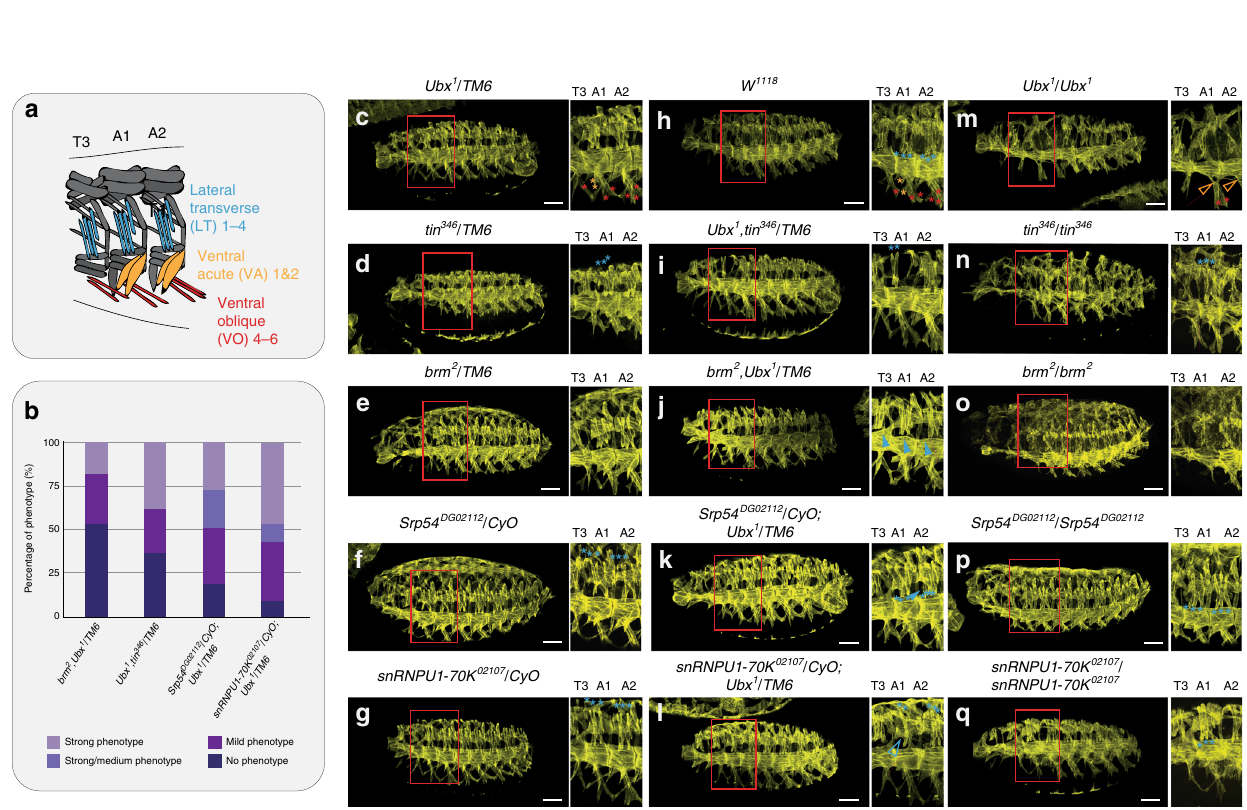
Fig. 6 Mesoderm-speci fi c functional cooperation of Ubx with BioID interactors. a Schematic illustration of the muscle patterns in the thoracic segment 3 (T3) and the fi rst two abdominal segments (A1, A2). Lateral transverse (LT) muscles are highlighted in blue, ventral acute (VA) muscles in orange and ventral oblique (VO) muscles in red, corresponding muscles in all the images are marked with asterisks or arrows in the indicated colours. b Quanti fi cation of muscle phenotypes in the indicated genotypes. Phenotype – genotype association was done by using LacZ staining driven by the marked balancer chromosomes. Strong and strong/medium phenotypes correspond to double homozygous mutants and mutants homozygous for one allele and heterozygous for the other. Embryos heterozygous for both mutant alleles showed either a mild phenotype or a hardly visible phenotype, categorized as “ no phenotype ” . c – q Immunostainings of stage 16 embryos of the indicated genetic backgrounds with tropomyosin (Tm1) to visualise the muscle pattern. While single heterozygous mutants ( c – g ) did not display any obvious muscle phenotype, double heterozygous mutants ( h – l ) had changed muscle morphology, which was distinct from the single homozygous mutant phenotypes ( m – q ). A signi fi cant loss of the lateral transverse muscles is detectable in Ubx 1 ,tin 346 /TM6-Dfd > lacZ ( i ), Srp54 DG02112 /CyO-wg > lacZ;Ubx 1 /TM6-Dfd > lacZ ( k ) and snRNPU1-70K 02107 /CyO-wg > lacZ;Ubx 1 /TM6-Dfd > lacZ ( l ) double heterozygous mutants indicated by blue asterisks and an open arrowhead. brm 2 ,Ubx 1 /TM6-Dfd > lacZ ( j ) double heterozygous mutant embryos show an aberrant muscle pattern indicated by the closed blue arrowheads. m Ubx 1 homozygous mutants show a homeotic transformation of A1 and A2 to T3 identity indicated by the missing asterisks (red, orange), while Srp54 DG02112 ( p ) and snRNPU1-70K 02107 ( q ) homozygous mutants show discrete muscle phenotype characterized by thinner muscles except tin 346 embryos that present a total loss of body wall muscle affecting the general aspect of embryos. Maximum Z-projections of lateral view are presented. Images are representative of 50 embryos analysed per genotype over 3 sets of pooled embryos from independent collection as quanti fi ed in b . Scale bar: 50 µ m. See also Supplementary Figs. 8 – 10. Source data are provided as a Source Data fi